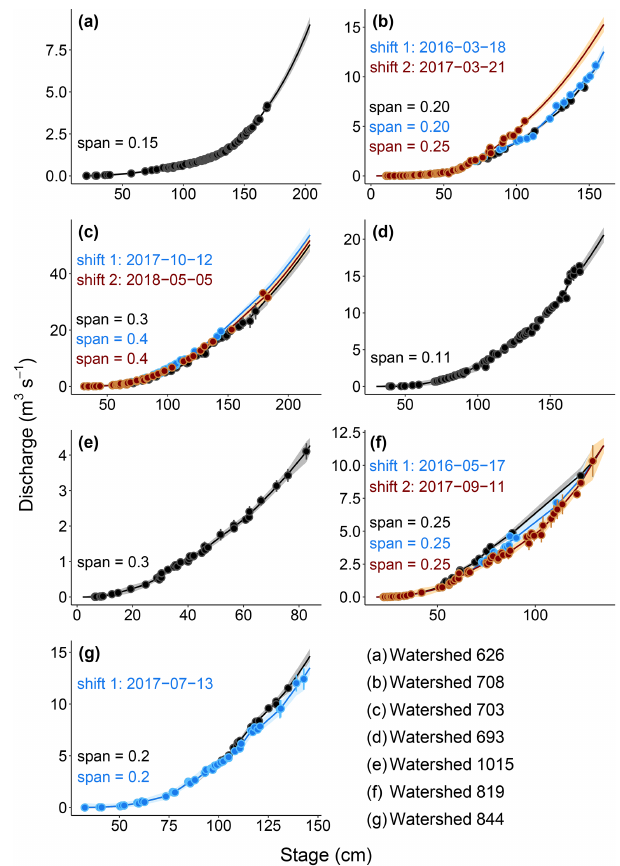
Figure 2. Stage discharge rating curves, with 95% confidence bands for the seven gauged watersheds. Large storm events caused rating curves to shift at some of the watersheds; dates are indicated for each individual shift. Rating curves were plotted using LOESS regression, and span widths (span) were visually selected for each individual